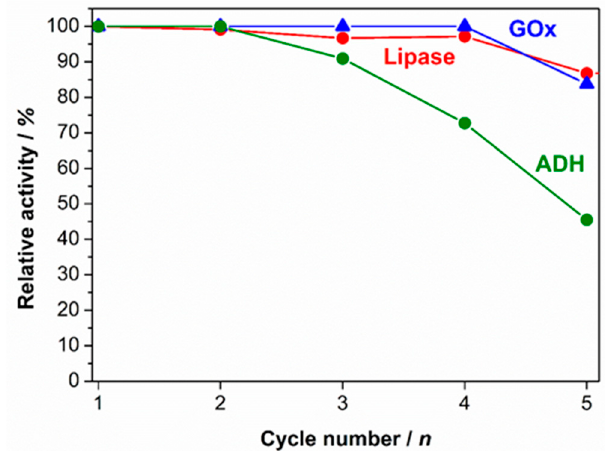
Figure 3. Relative catalytic activity during 5 reaction cycles with the biocatalysts prepared in one step, formed by the semicrystalline Fe-BTC material as a support and the enzymes glucose oxidase@GOx (blue), lipase@Lip (red), or alcohol dehydrogenase@ADH (green) as the active species. The catalytic activity was measured for an optimized reaction for each enzyme for enzymatic activity assays) and is compared to the catalytic activity of each biocatalyst in its first reaction cycle, which was taken to be 100 %. Reproduced with permission from [12].Copyright Wiley-VCH Verlag GmbH & Co. KGaA.